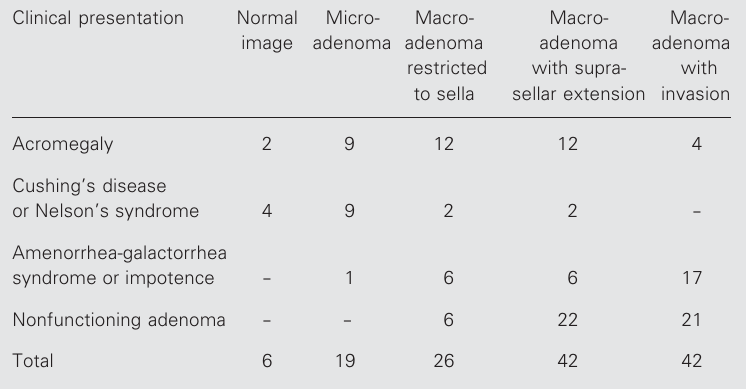
Table 1. Sellar imaging data for patients with pituitary adenomas. Clinical